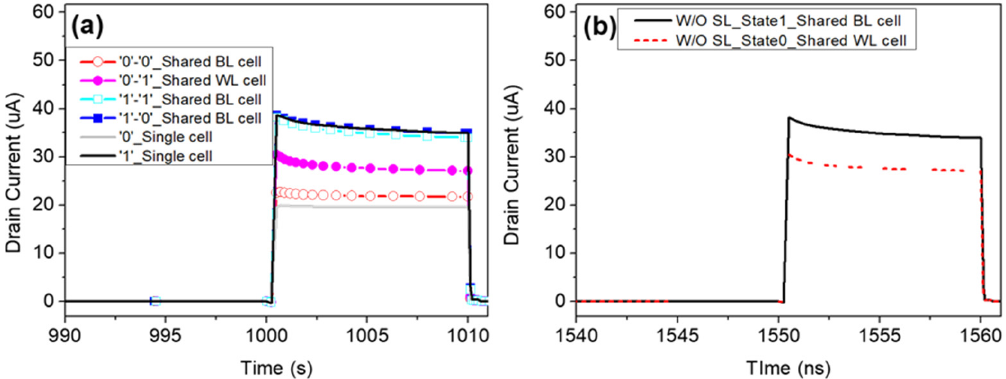
Figure 7. Read current of ( a ) worst cell for each case and single device and ( b ) worst cell for each state in all cases. Table 3. Read current values of the worst case in each state at 10 ns after application of the read voltage.